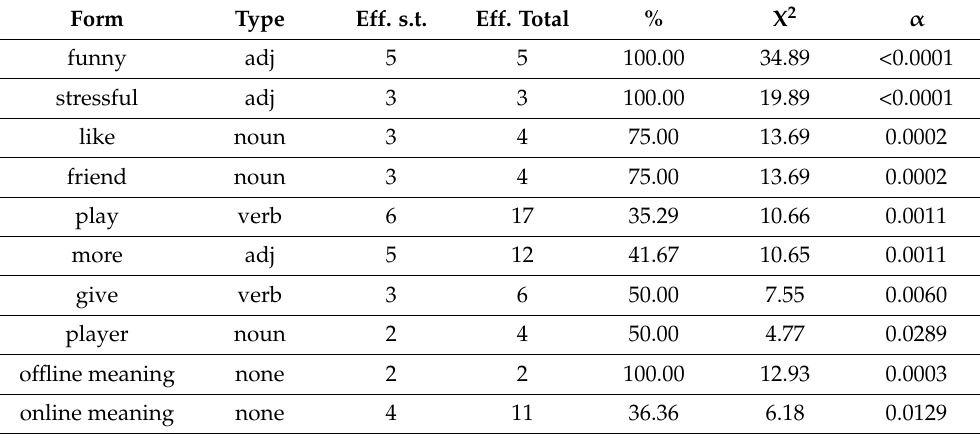
Table 5. More frequent words in class 5: Meaning to play offline.